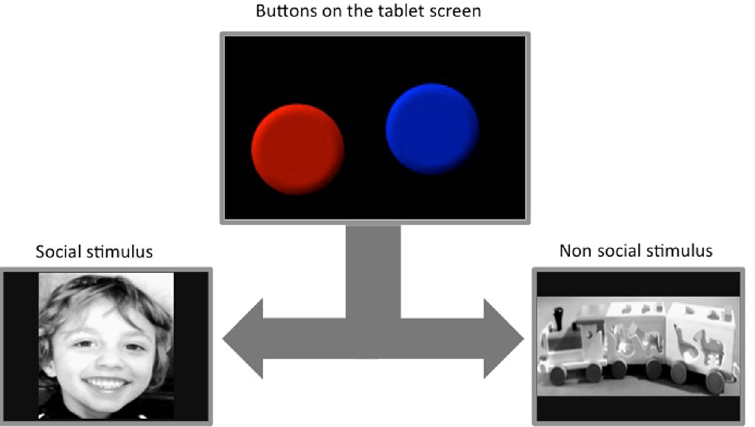
Figure 1. Schematic representation of a trial. The child would press one of the buttons on the screen in order to reveal either of the two pictures. These pictures would last for 3s, and then be replaced by the screen with the buttons after an inter-trial interval of 3s. Pictures used in this figure are representative, due to copyright